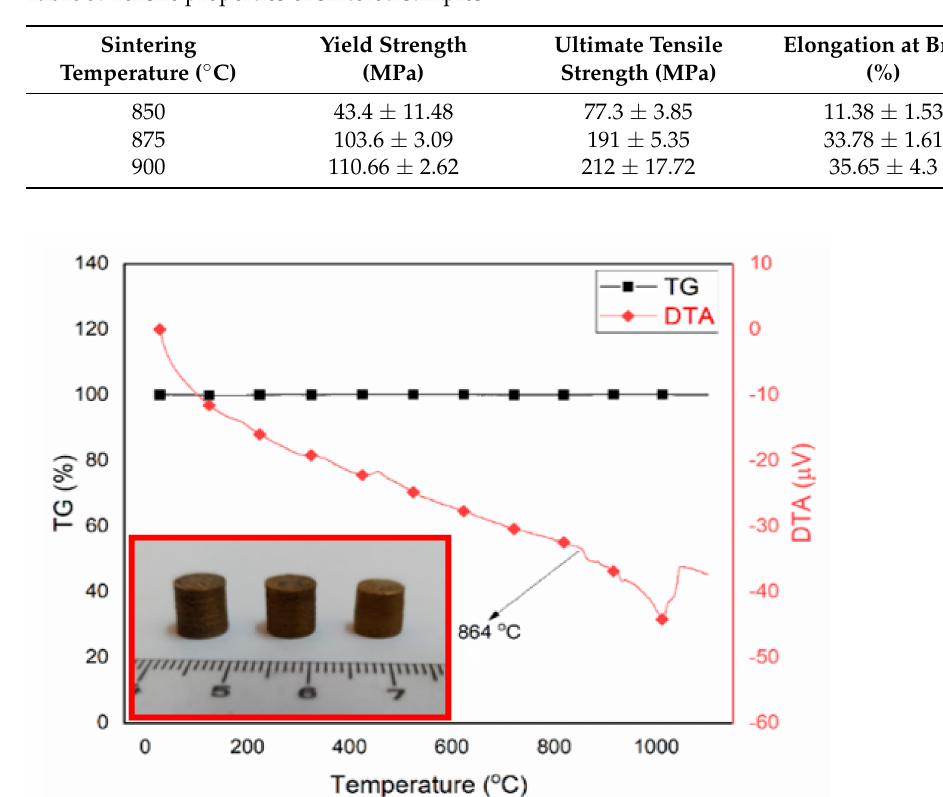
Figure 9. Shape distortion test samples sintered at 850 to 900 ◦ C from left to right and TG/DTA graph of bronze powder.